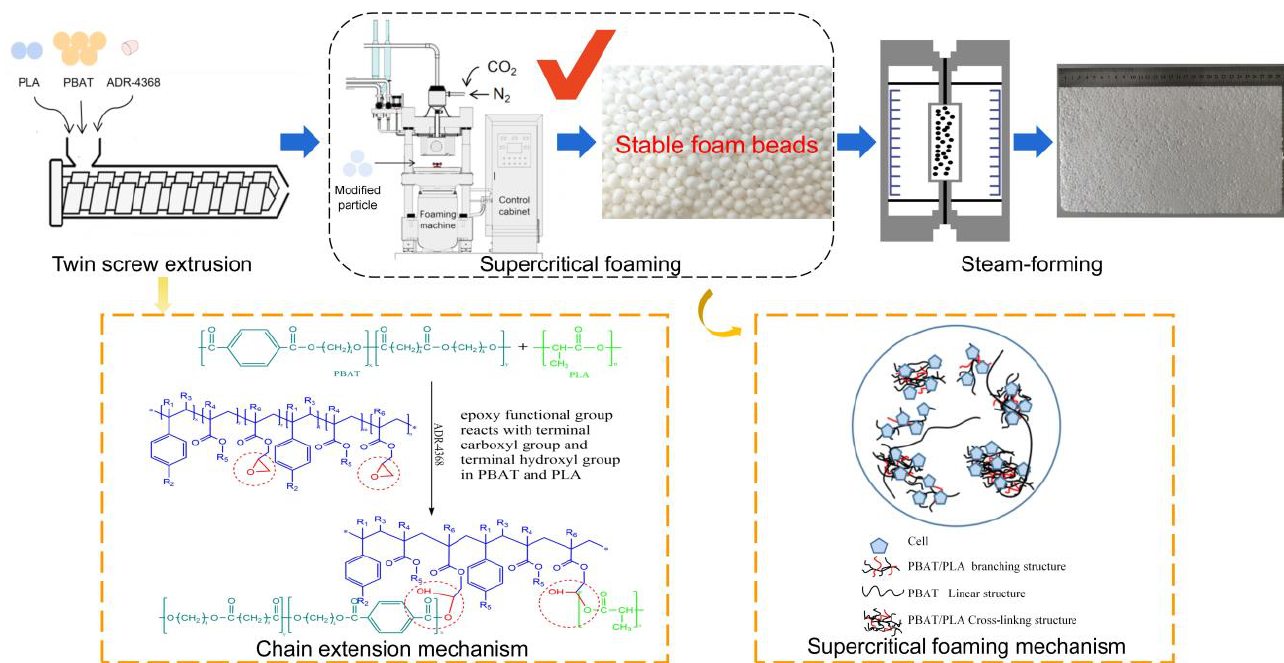
Scheme 1. Experiments on supercritical bead composite gas foaming of chain extended PBAT/PLA and reaction-mechanism diagram.